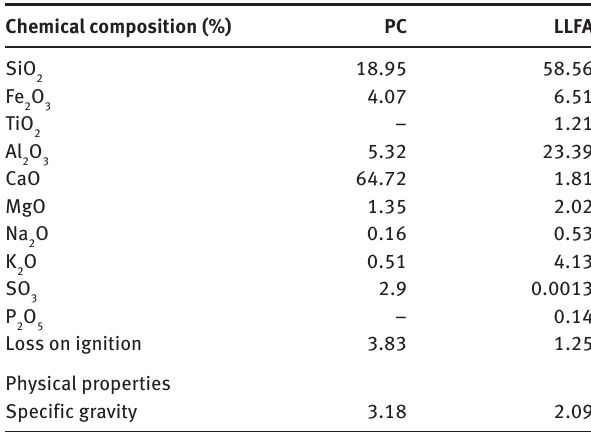
Table 1: Chemical composition and physical properties of the PC